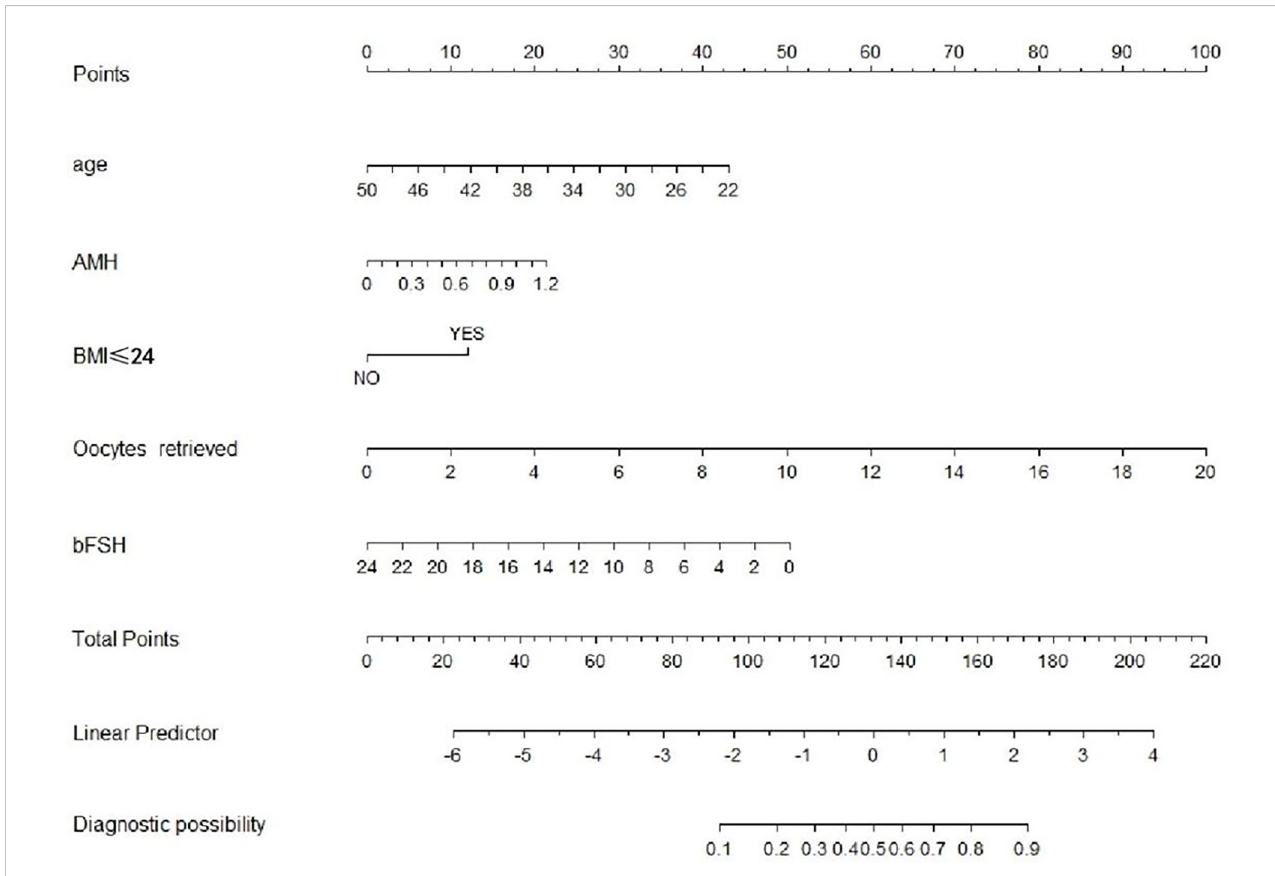
FIGURE 1 Nomogram for predicting the probability of live birth in patients with expected